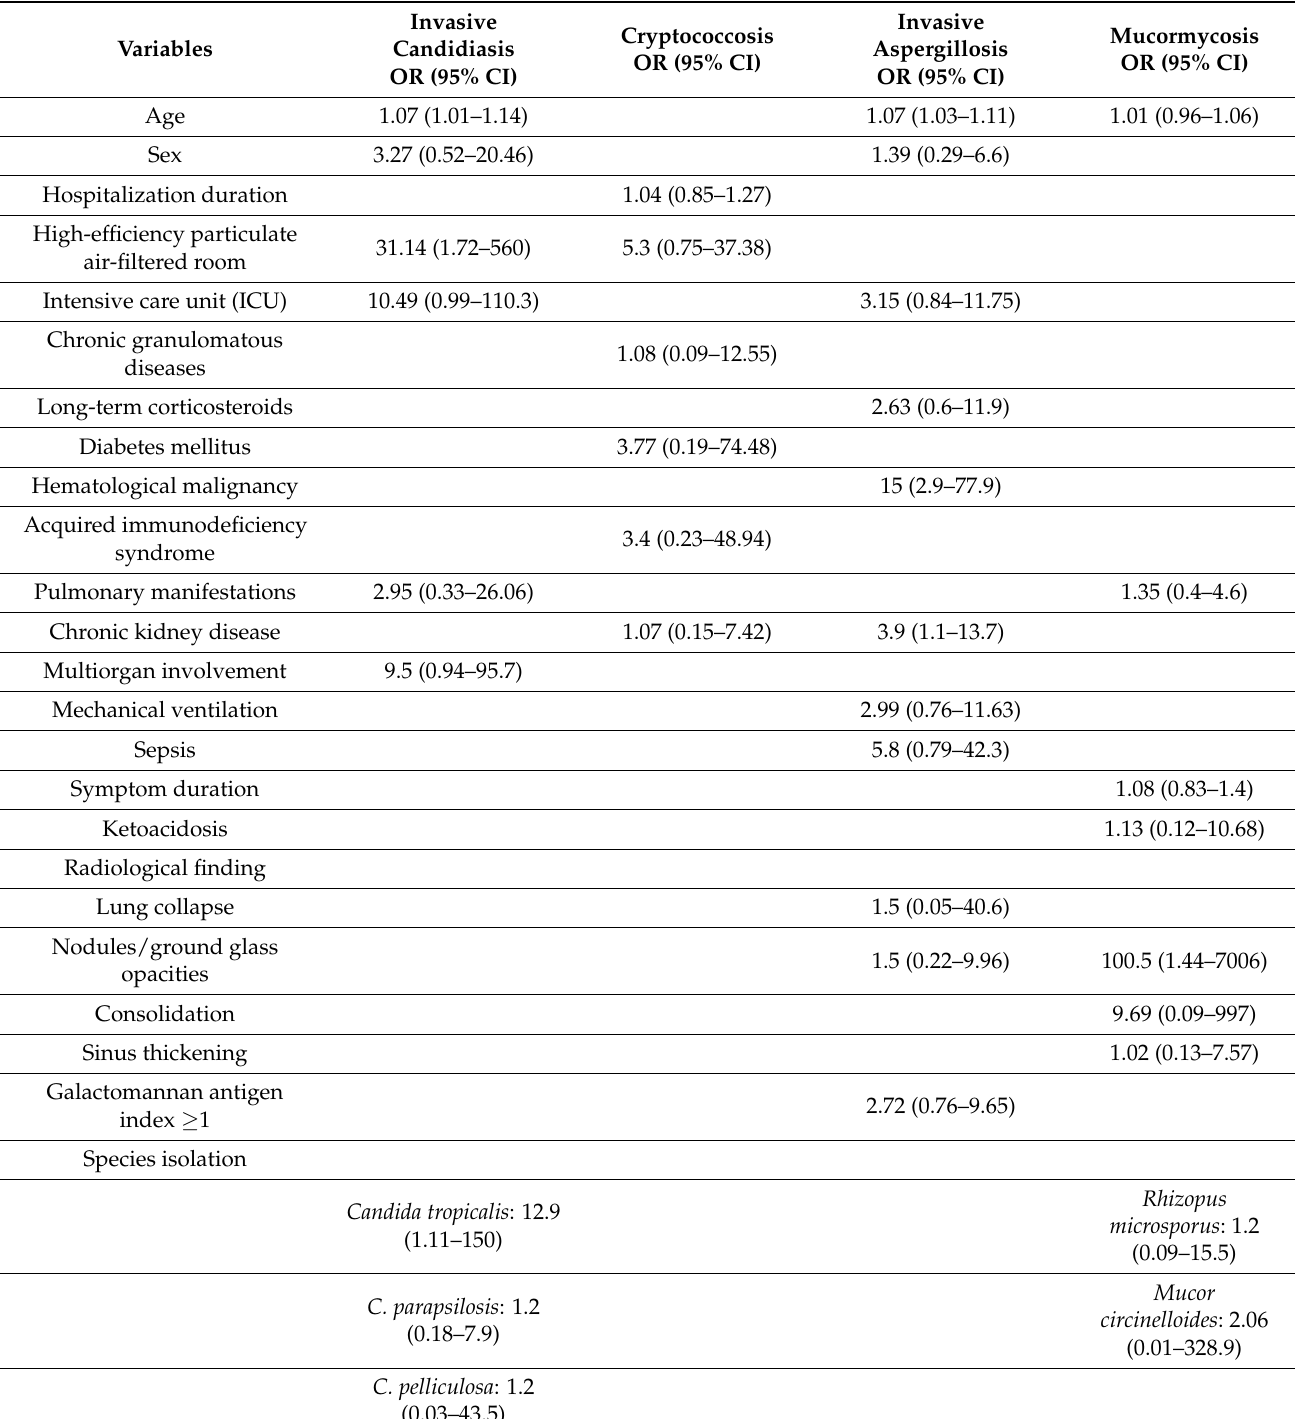
Table 3. Multivariate analysis showing the interdependent variables as significant predictors of mortality in different